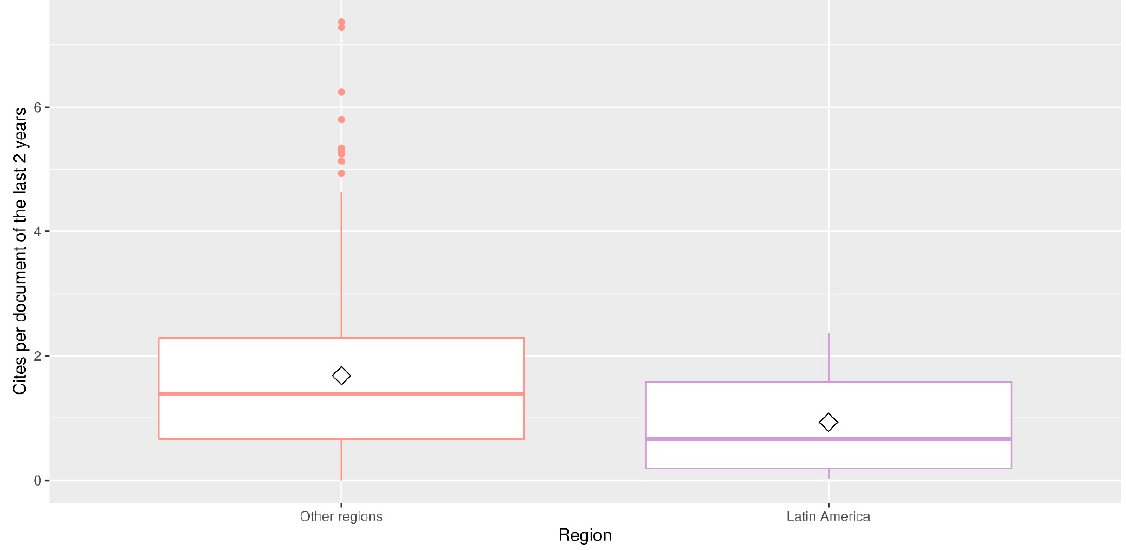
Figure 8. Comparison of citations per document between LAC and other regions.